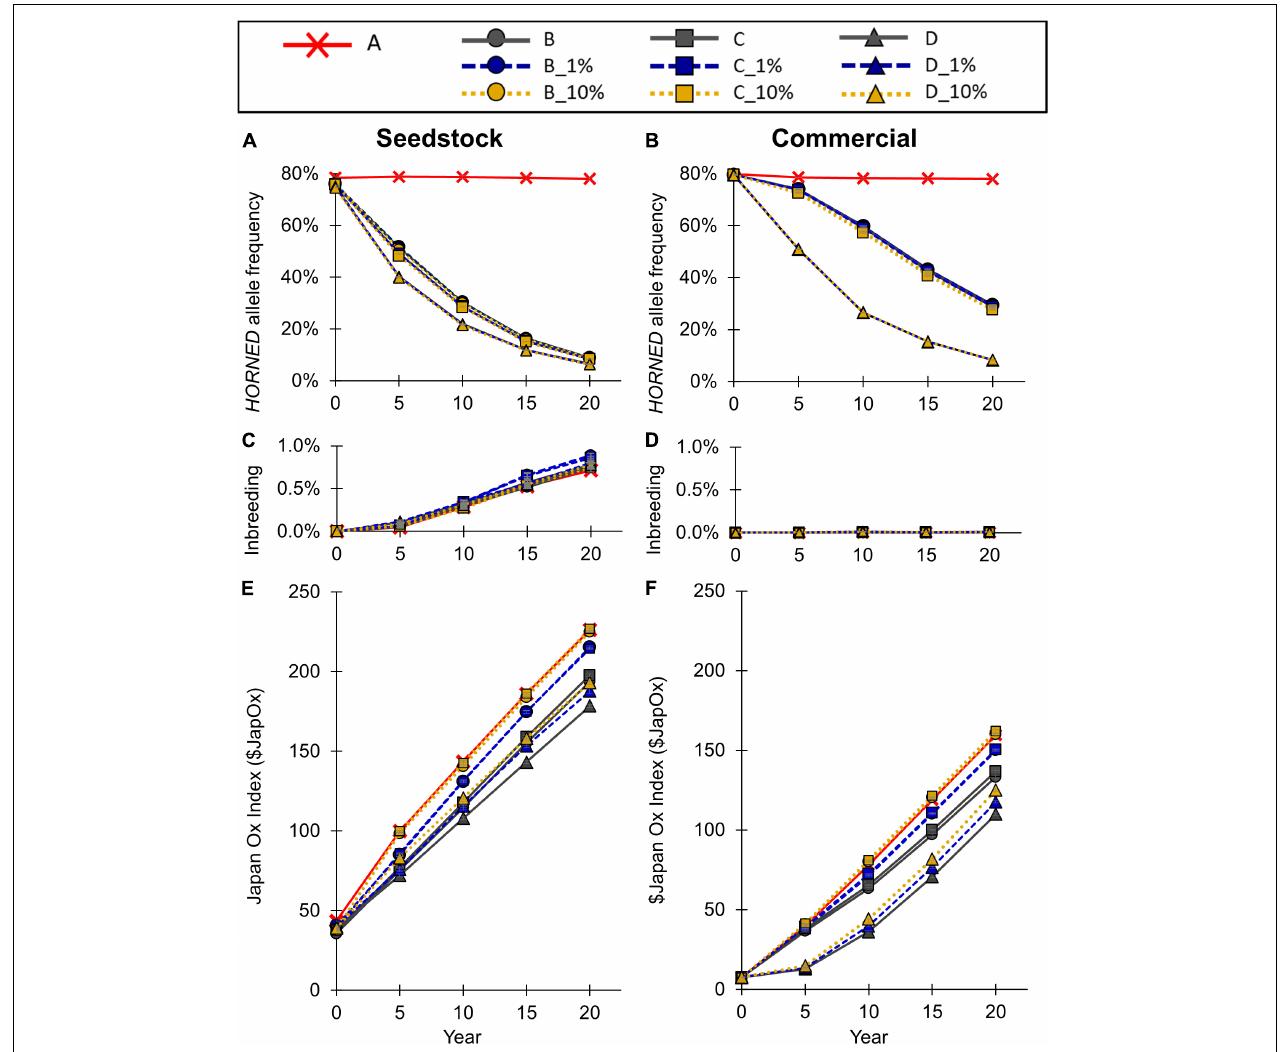
FIGURE 5 | Effect of each scenario on (A,B) HORNED allele frequency, (B,C) inbreeding, and (E,F) genetic merit for the seedstock (A,C,E) and commercial (B,D,F) populations. Conventional breeding scenarios (A,B,C,D) are solid lines, gene editing 1% scenarios (B_1%, C_1%, D_1%) are dashed lines, and gene editing 10% scenarios (B_10%, C_10%, D_10%) are dotted lines. Error bars represent